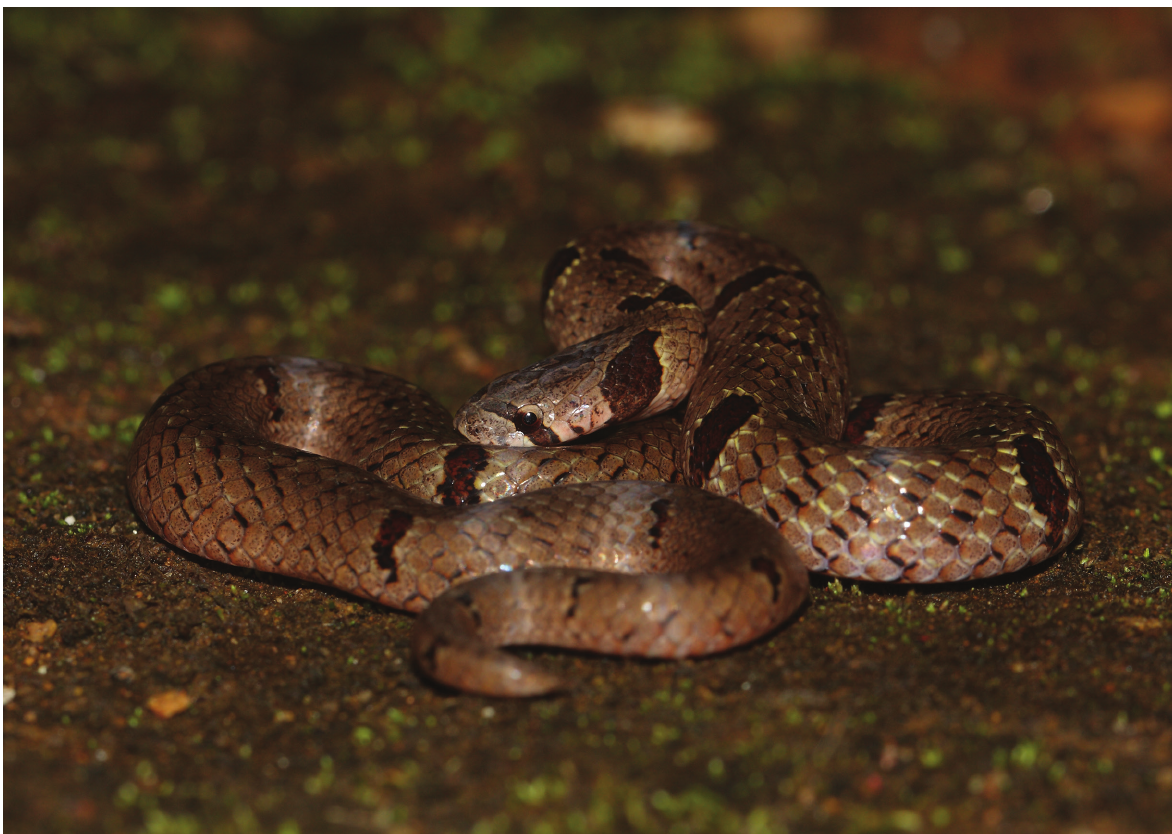
Figure 1. A live male of Oligodon sublineatus (not collected) at Sinharaja Forest Reserve, Sri Lanka (photo: H. Table 1. Morphometric and meristic characters of Oligodon sublineatus lectotype (MNHN 3238) and paralectotype (MNHN 3239).